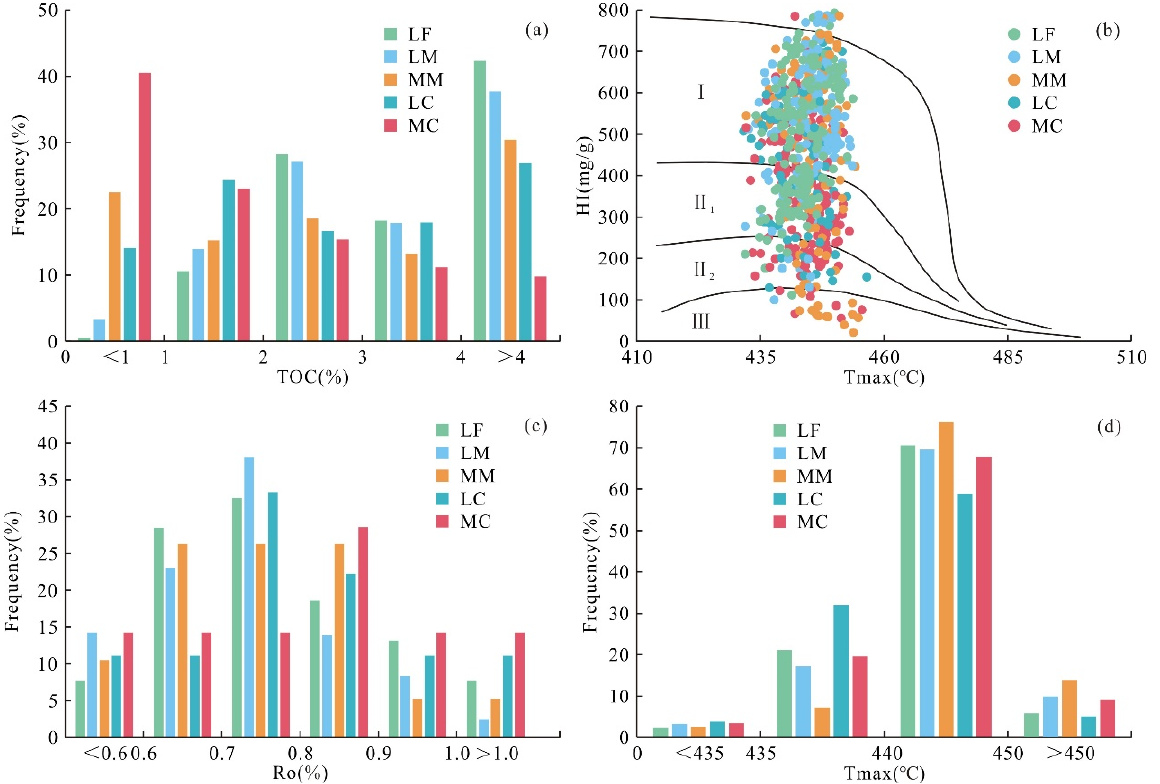
Figure 6. Basic organic geochemical characteristics of the Ek 2 shales in the Cangdong Sag. ( a ) Frequency distribution histogram of TOC. ( b ) Frequency distribution histogram of Ro. ( c ) Frequency distribution histogram of T max . ( d ) Plot of HI versus T max , showing the organic matter types. LF: laminated felsic shale; LM: laminated mixed shale; MM: massive mixed shale; LC: laminated carbonate shale; MC: massive carbonate shale.